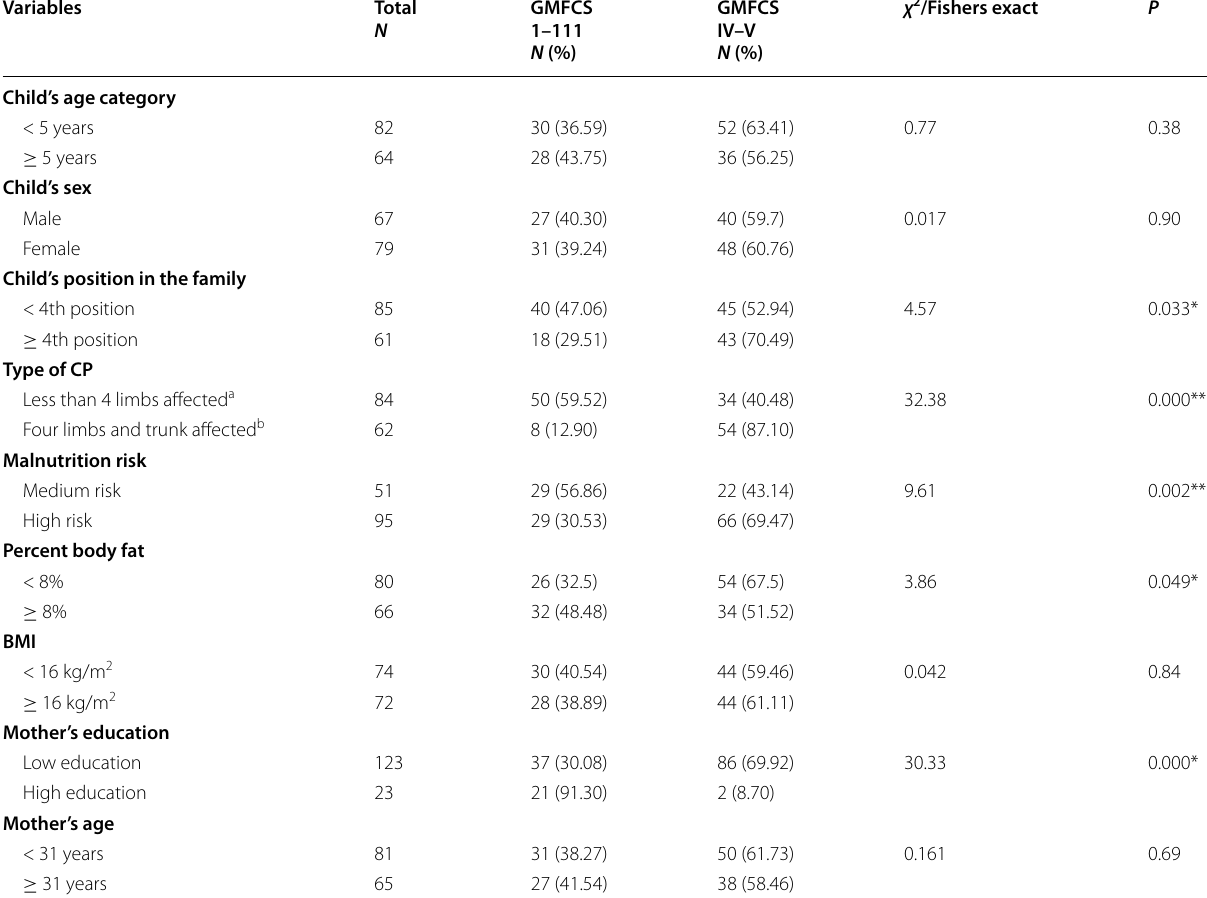
Table 3 Association between gross motor function, malnutrition risk, and each of child and caregiver-related variables ( N